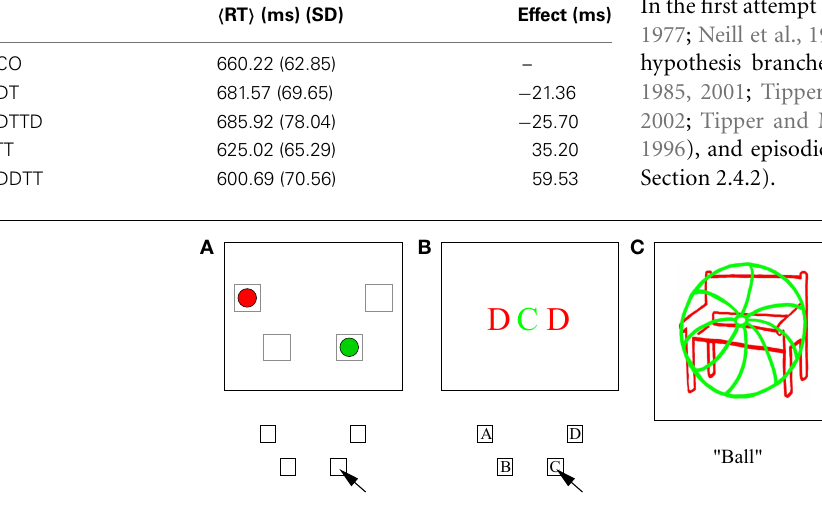
FIGURE 2 | Four different paradigms for NP. (A) The location priming paradigm reveals NP in the encoding of space. (B) The flanker task implements a stimulus response mapping. (C) Responses are given as vocalization in the